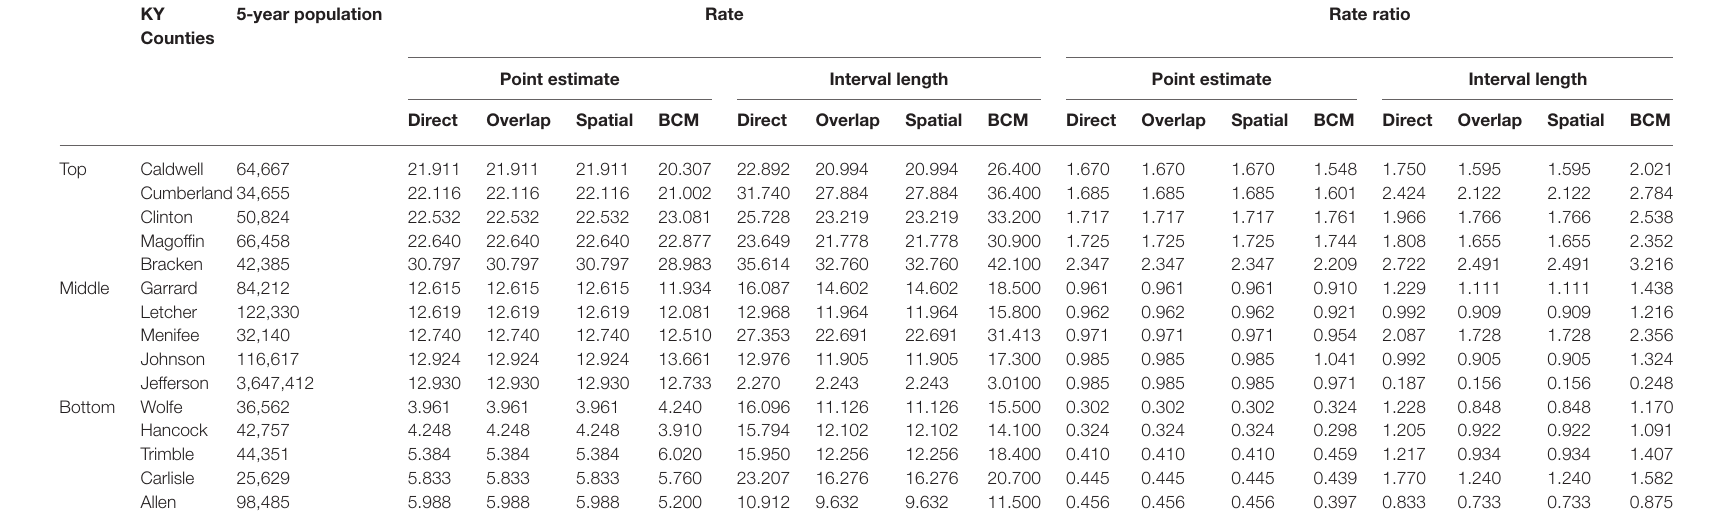
TABLE 5 | Age-adjusted rate and rate ratio in top, middle, and bottom five counties based on 2006–2010 oral cancer incidence rate in